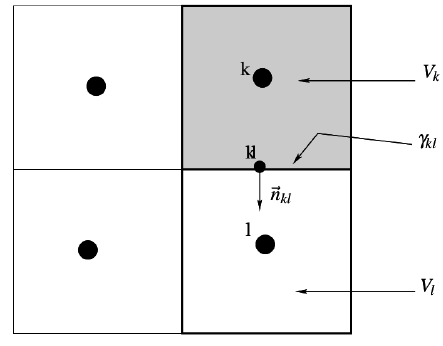
Figure 2. Discretization by the cell-centered finite volume